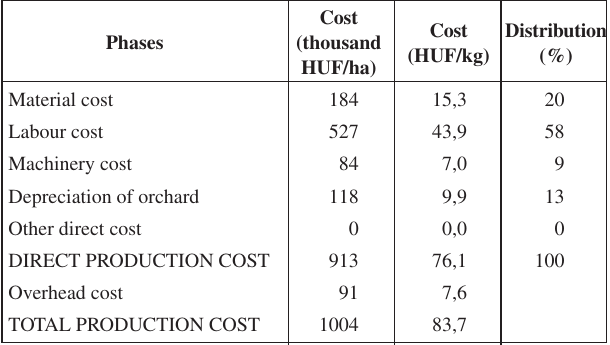
Table 2. Costs of sour cherry production by cost-type-structure (per